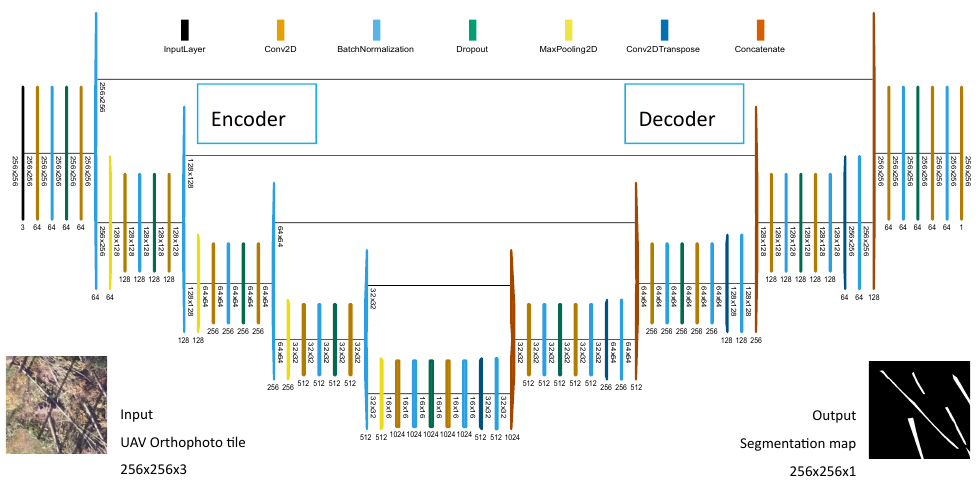
Figure 4. U-Net architecture consisting of an encoding and a decoding branch with skipping connec- tions between the corresponding layers. The number of features is noted below the layers and the input ( left ) and output ( right ) dimensions are provided beside each